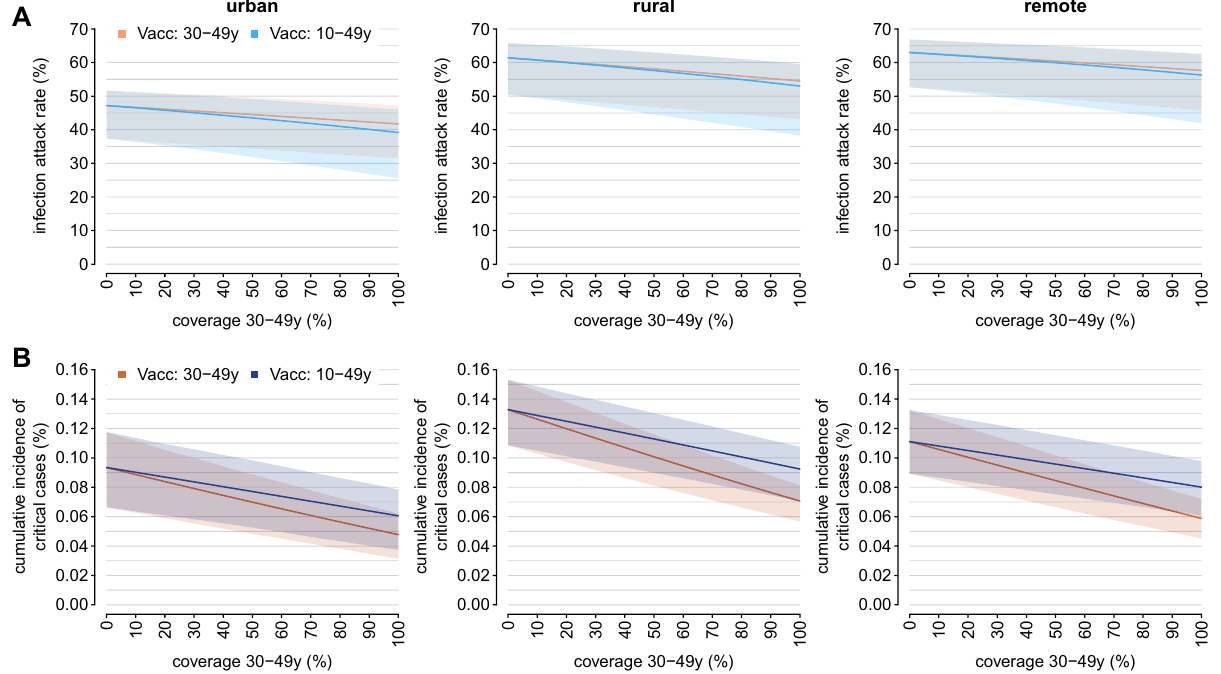
Figure 4. Estimated infection attack rate ( A ) and cumulative incidence of critical cases ( B ) in urban, rural, and remote areas, as obtained under the assumption that all individuals above 50 years are vaccinated with two doses and by considering different scenarios for the number of additional doses that would be available. In each panel, two strategies are compared: in the first, a further vaccination effort is simulated to reach a specific coverage level in subjects aged 30–49 years (orange); in the second, the same number of doses is used to uniformly vaccinate individuals aged 10–49 years (blue). Solid lines represent the mean model estimates; shaded areas represent the 95%